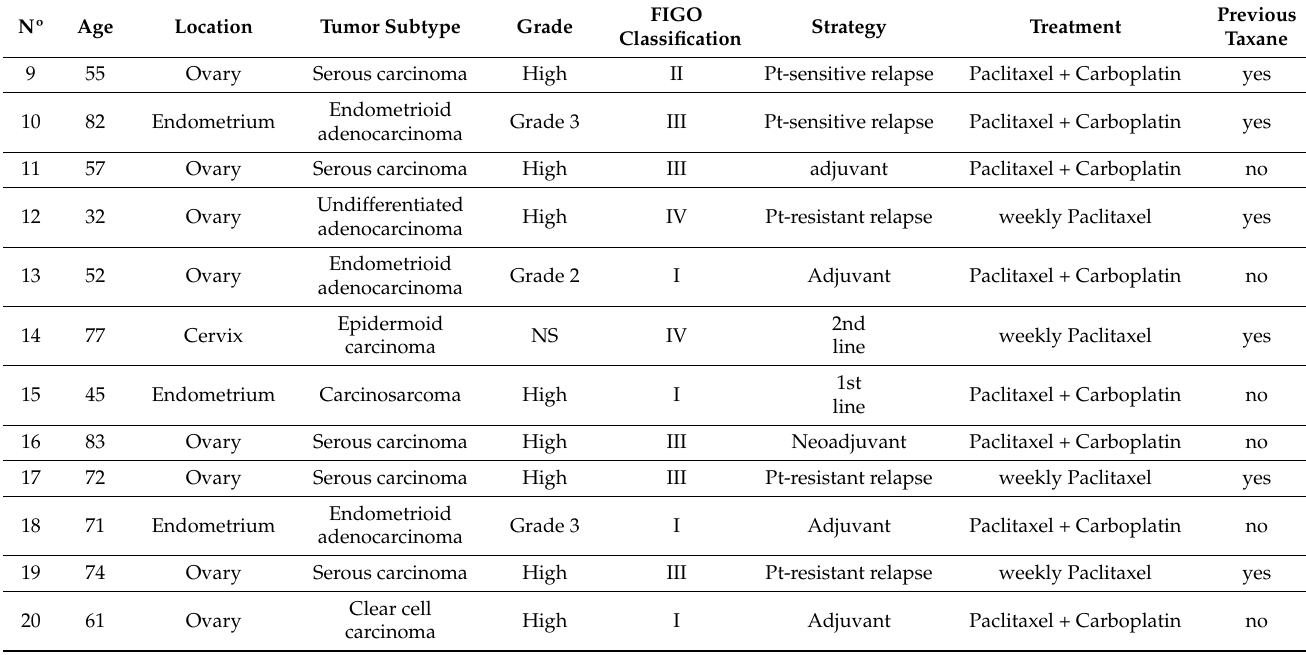
Grade: Depends on the cancer aggressiveness—for endometrial and endometrioid-type ovarian tumors, grades are classified according to the classic system from 1 to 3. For ovarian tumors, the current high-grade versus low-grade grading system is shown. Stage: International Federation of Gynecology and Obstetrics (FIGO) classification scale from I to IV. Strategy: For endometrial and cervical tumors, it is reported whether it was for localized disease (adjuvant) or the number of chemotherapy lines for advanced disease (1st line or 2nd line). For ovarian tumors, it is reported if the strategy was for localized disease (adjuvant or neoadjuvant) or advanced disease according to previous platinum sensitivity (platinum-sensitive or platinum-resistant). Refractory cancers were categorized as platinum-resistant. Treatment: weekly paclitaxel (80 mg/m 2 ) was administered at days 1, 8, and 15